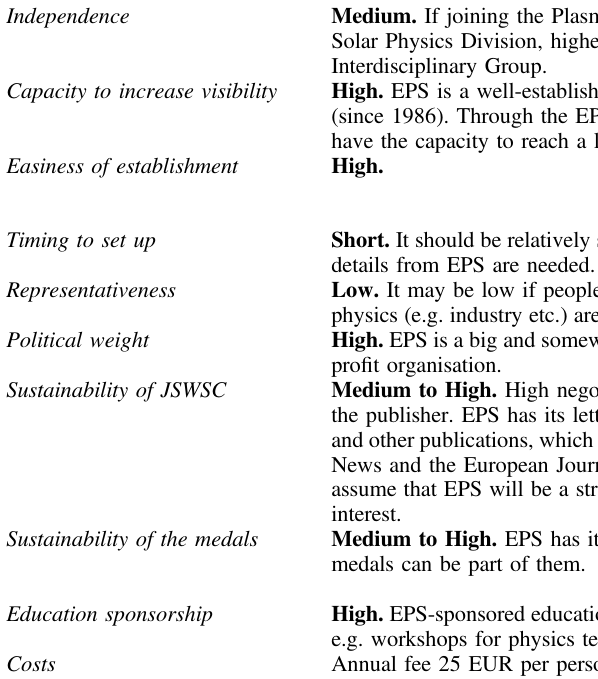
Table 2. Weighting criteria to compare EPS and INPA (TBD = to be assesed in due course). Weighting criteria EPS